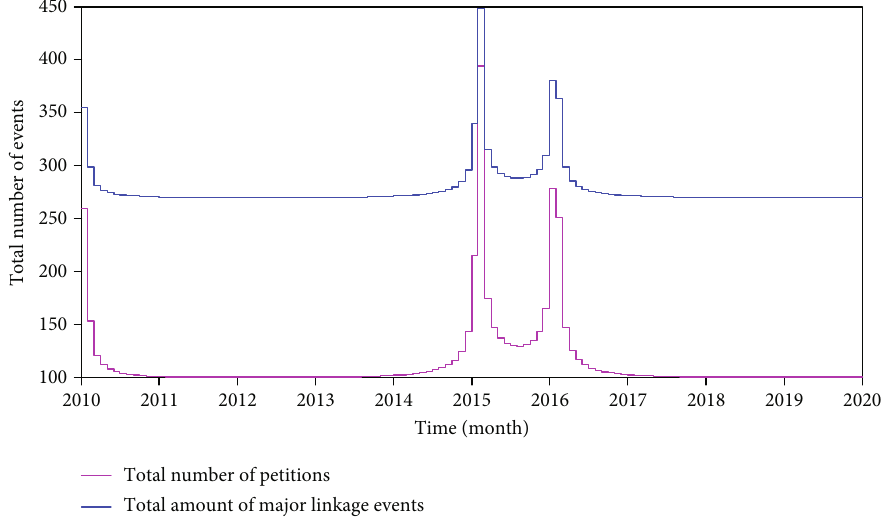
Figure 4: Comparison of the total number of major linkages and